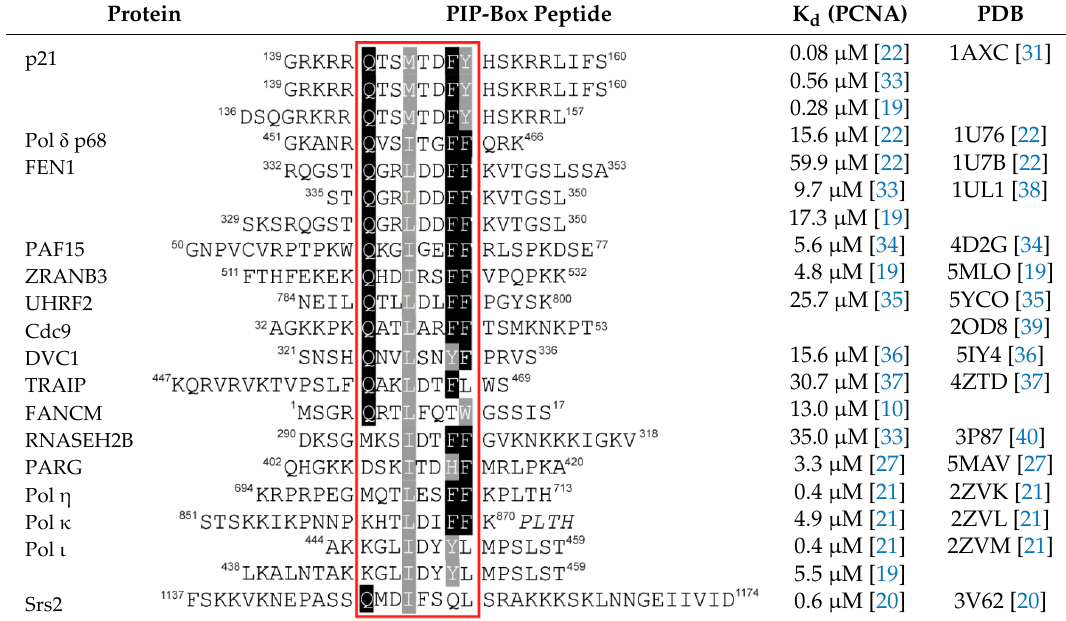
gap. Black dashed arrows indicate PCNA targets in different pathways. RPA (replication protein A); CtIP (CtBP-interacting protein); MSH2 (MutS homologue 2); MSH6 (MutS homologue 6); MLH1